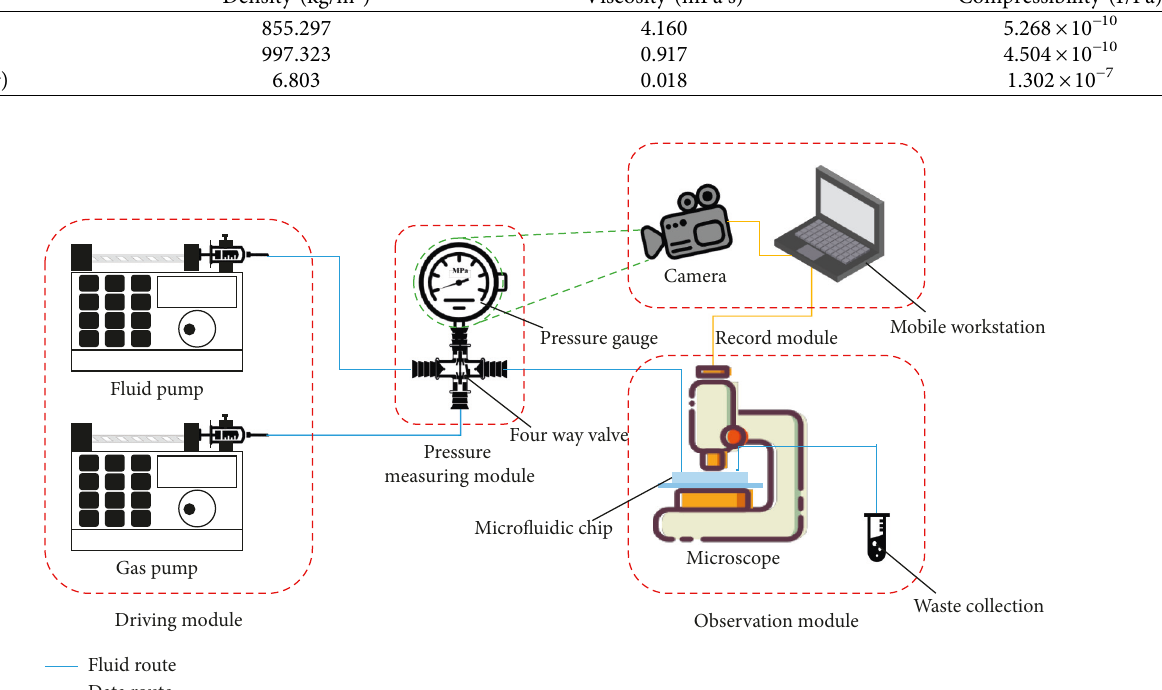
algorithm, the pore structure generated by improved QSGS algorithm, the mask pattern for microfluidic chip fabrica- tion, and the fabricated microfluidic chip are shown in Figure 4. The size ratio on pore structure generated by improved QSGS algorithm, mask pattern, and microfluidic chip are 1 :1 :1 particularly.